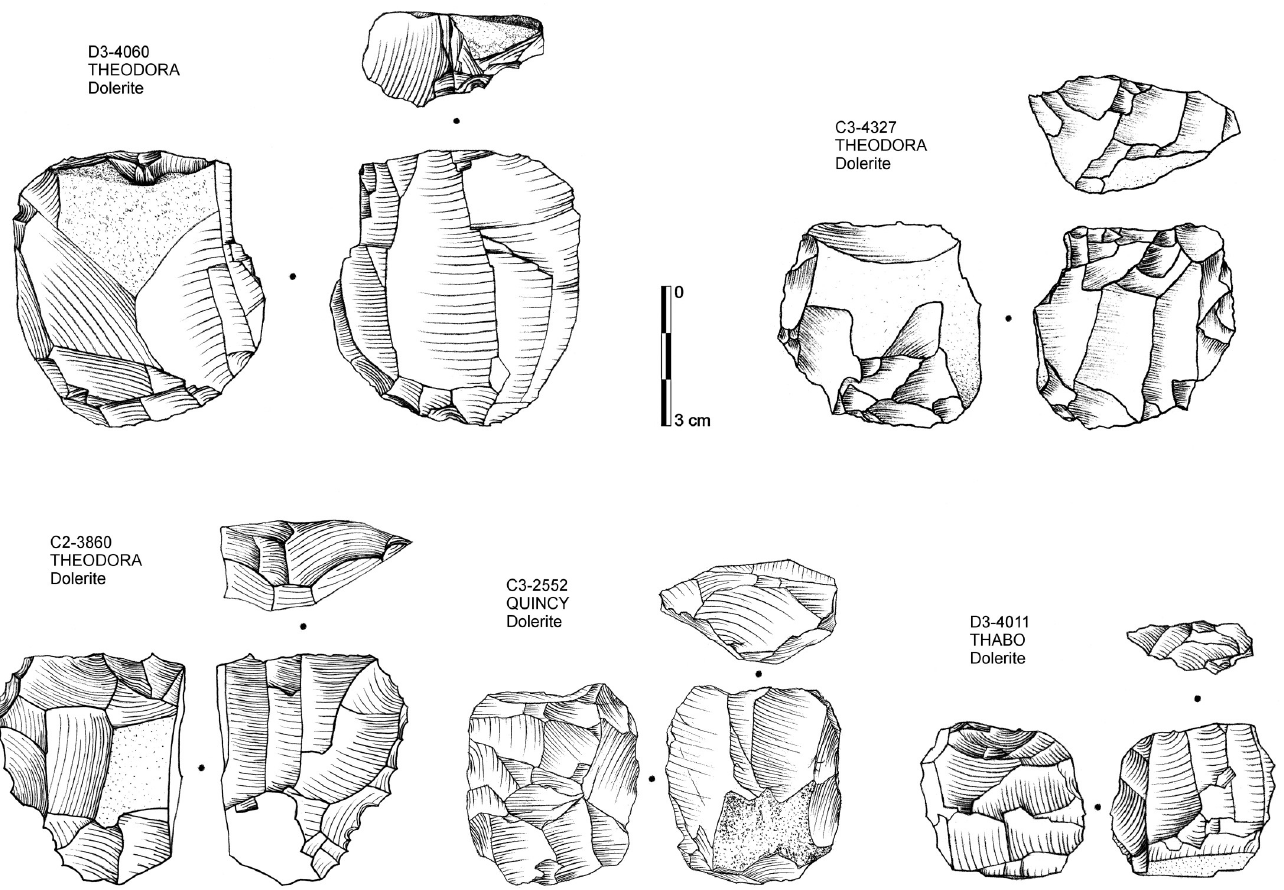
Fig 5. Drawings of HP cores from Sibudu with indication of find number, raw material and layer. https://doi.org/10.1371/journal.pone.0239195.g005 (60.0%), SARAH and SAMAN (51.6%), THEODORA and THABO (38.5%). A closer look at individual assemblages (Table 7) and by Abtra¨ge (S9 Table in S1 File; S4 Fig in S2 File) illus- trates that this trend is not monotonous, but the Kendall’s tau-b correlation supports the over- all linear trend from bottom to top by Abträge ( τ = 0.356, p = 0.013; n = 25). A combined test b Table 7. Frequency of tool types (n) for each lithic assemblage and the entire Sibudu HP. Layer Backed piece Notch. & Bifacial point Unifacial point Side scraper Lateral Splintered piece Strangulated piece Minimal Dent. retouch